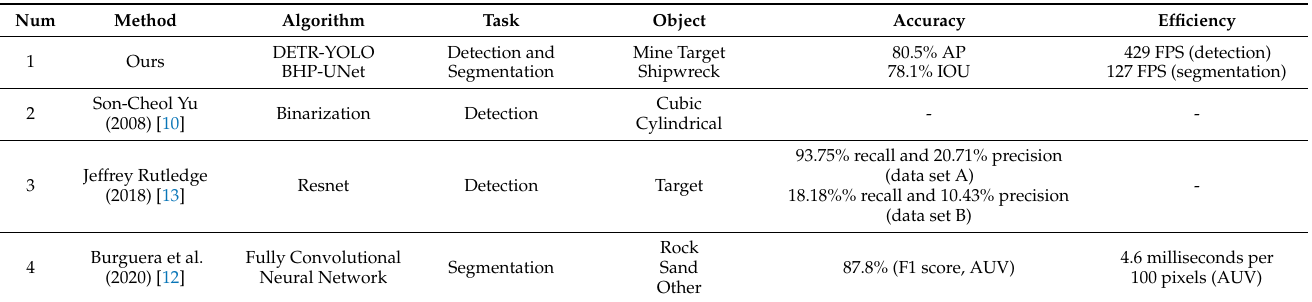
Table 10. Comparison of our method with the existing AUV-based real-time underwater-object detection